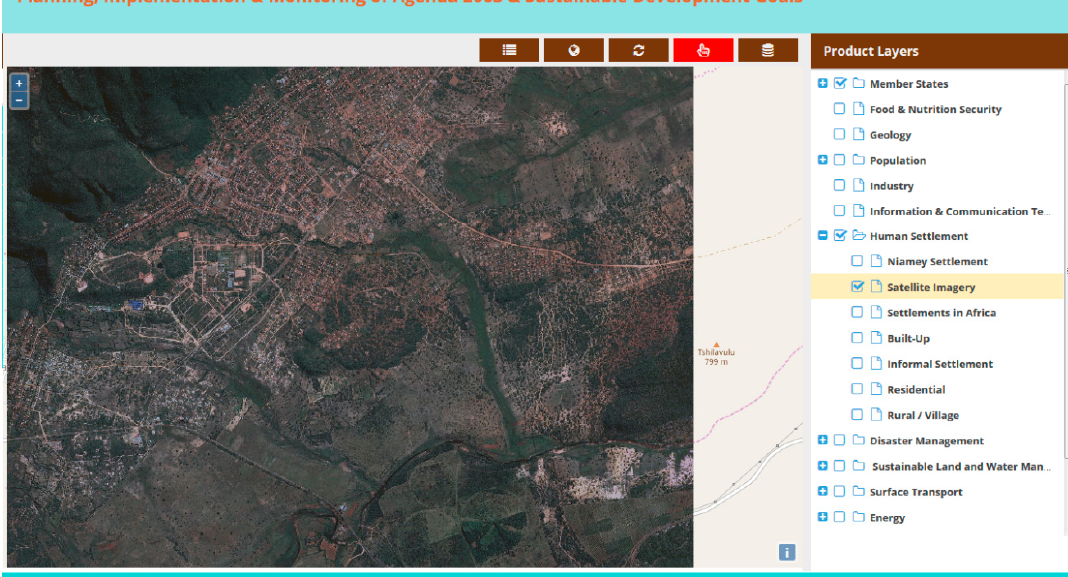
Figure 18. Satellite image data overlays.